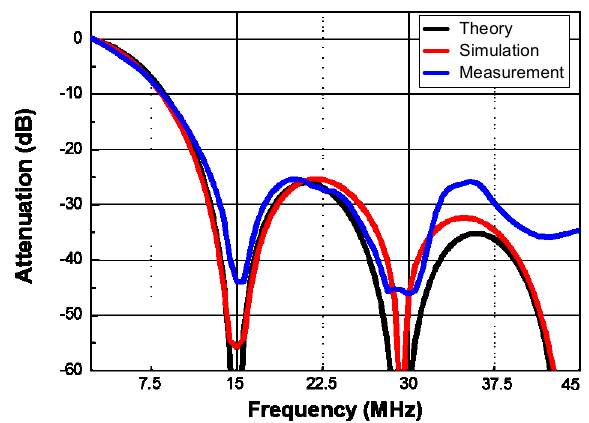
Figure 5. Frequency response of the proposed low hardware complexity discrete-time filter.